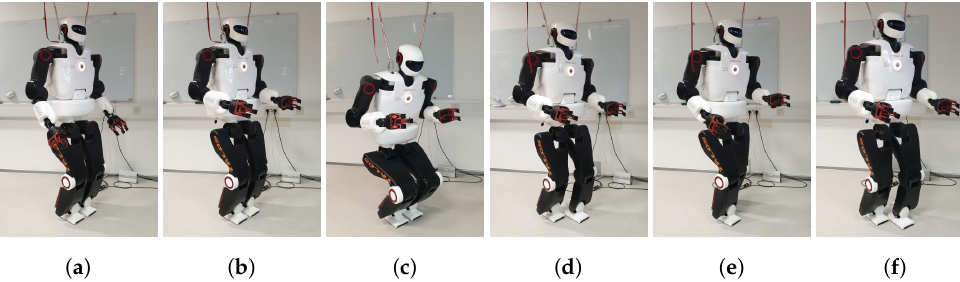
Figure 5. ( a – f ) Photos of the humanoid robot Talos in gaits that correspond to different states of the PSS guided by the SHC networks, as described in the